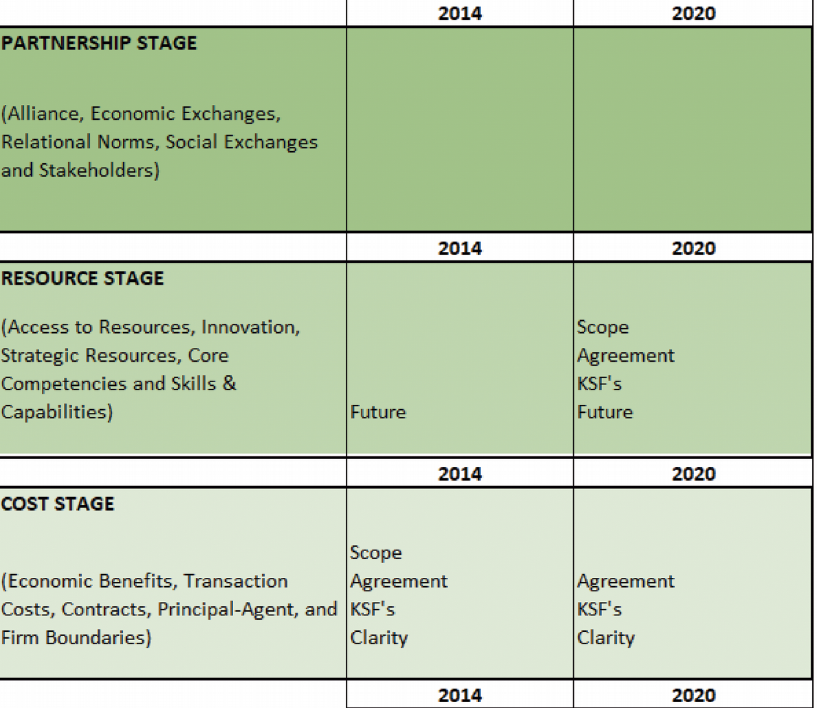
Table 5. Maturity assessments of the interview results for